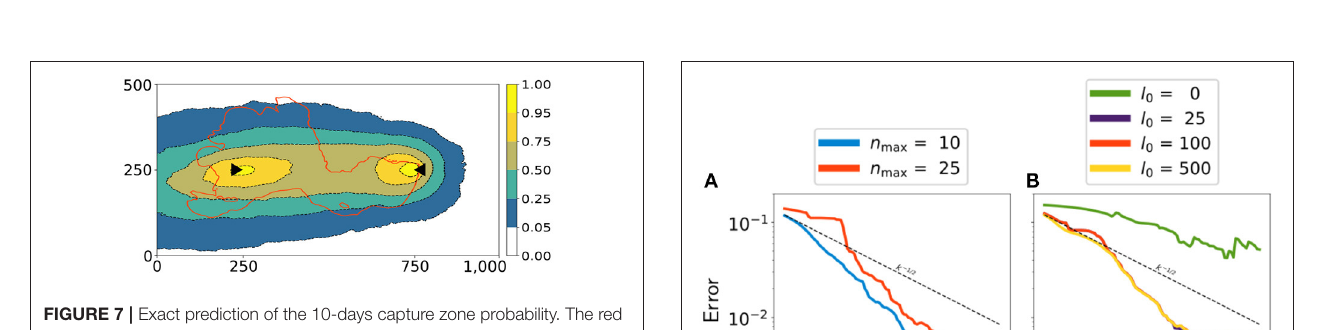
FIGURE 7 | Exact prediction of the 10-days capture zone probability. The red lines delineates the capture zone in the reference domain.